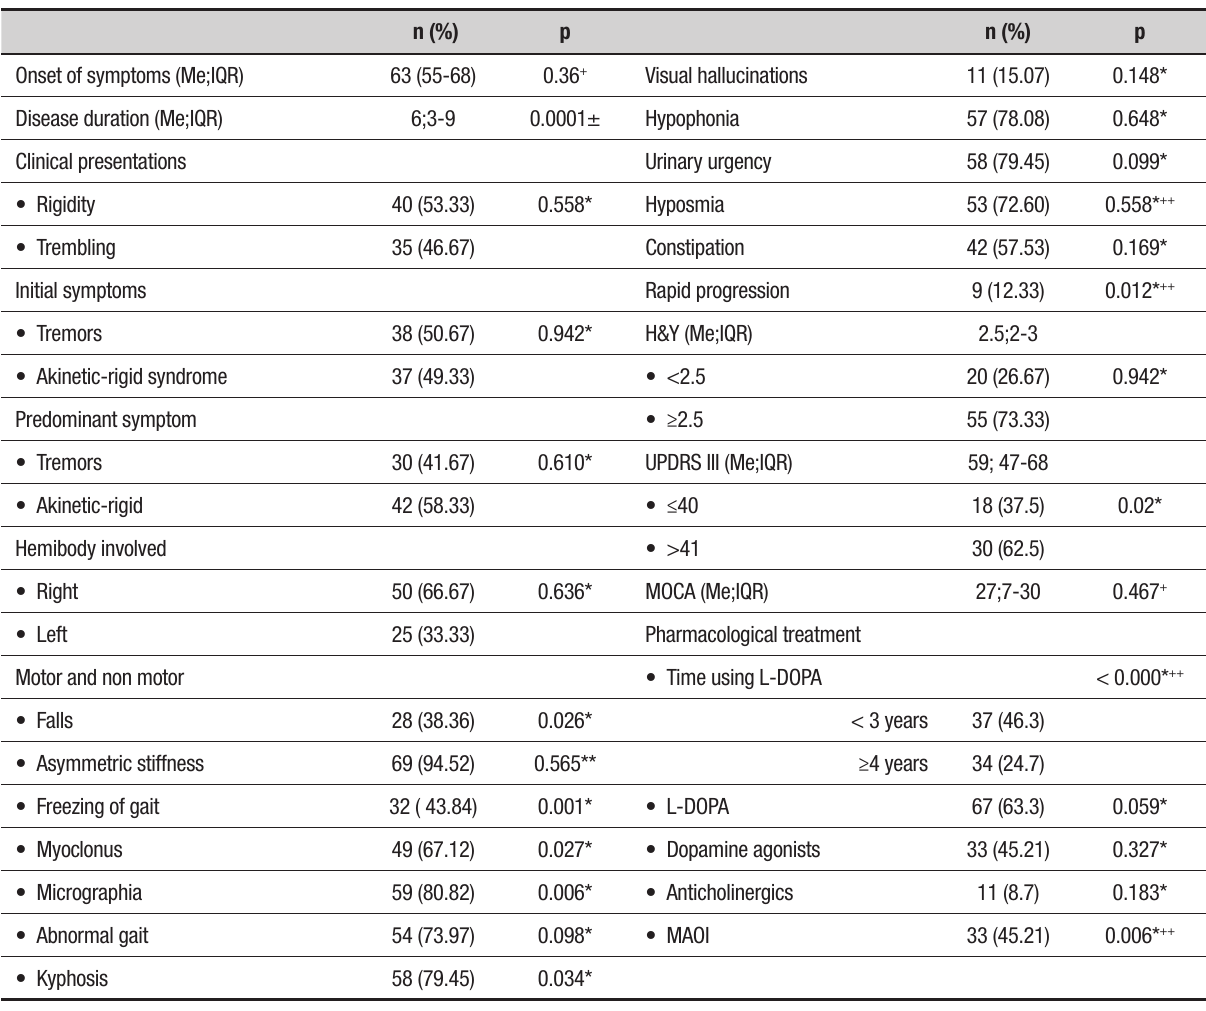
Table 3. Clinical and pharmacological characteristics of PD patients with